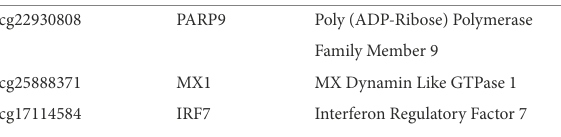
TABLE 3 Essential methylation sites and their corresponding genes for distinguishing severity of SARS-CoV-2 infection. Methylation sites Gene symbol